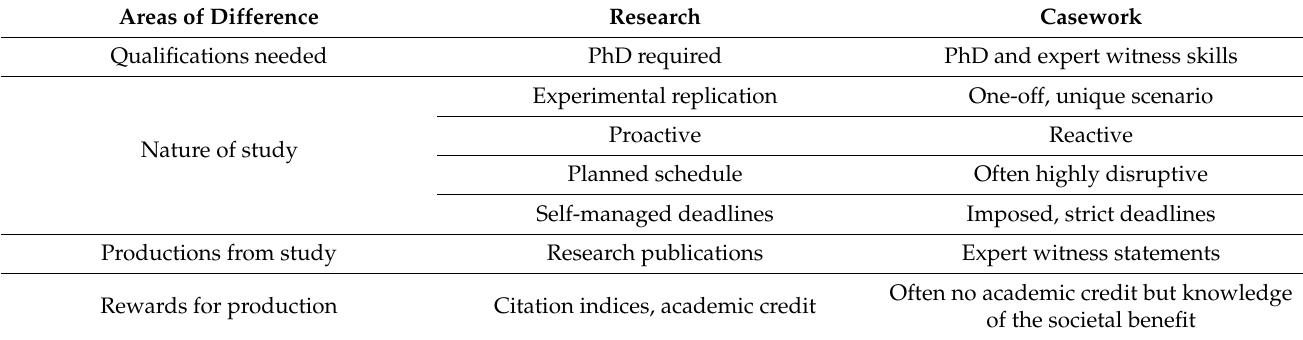
Table 1. Some differences between research and casework in forensic